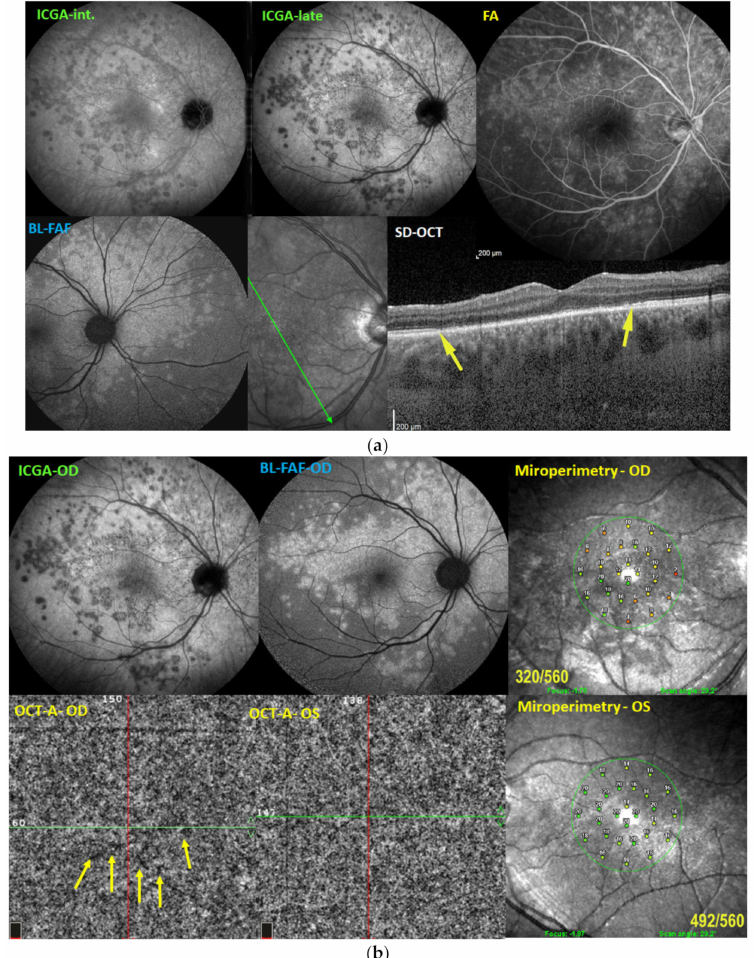
Figure 8. ( a ) Illustrative case of MEWDS, multimodal imaging. Scattered areas of hypofluorescent dots seen on intermediate angiographic phase of ICGA (ICGA-int, top left ), much better identified on the late phase frame ( top middle , ICGA-late). FA ( top right ) shows faint hyperfluorescence in the same areas. BL-FAF shows hyperautofluorescent area corresponding to ICGA hypofluorescence due to loss of photoreceptor outer segments and better visualization of the normal RPE lipofuscin autofluorescence. Loss of photoreceptor outer segments is shown on the SD-OCT section between the yellow arrows ( bottom right ). ( b ) Illustrative case of MEWDS: OCT-A and microperimetry. Extensive areas of end-capillary non-perfusion on ICGA ( top left ) corresponding to hyperautofluorescence ( top-middle ) due to loss of photoreceptor outer segments as explained in paragraph 2.2. OCT-A of the MEWDS eye (OD) shows tiny areas of choriocapillary drop-outs. Although the Octopus ® visual field was normal, microperimetry of the MEWDS eye showed a decreased retinal sensitivity ( top right ) compared to the fellow normal eye ( bottom right